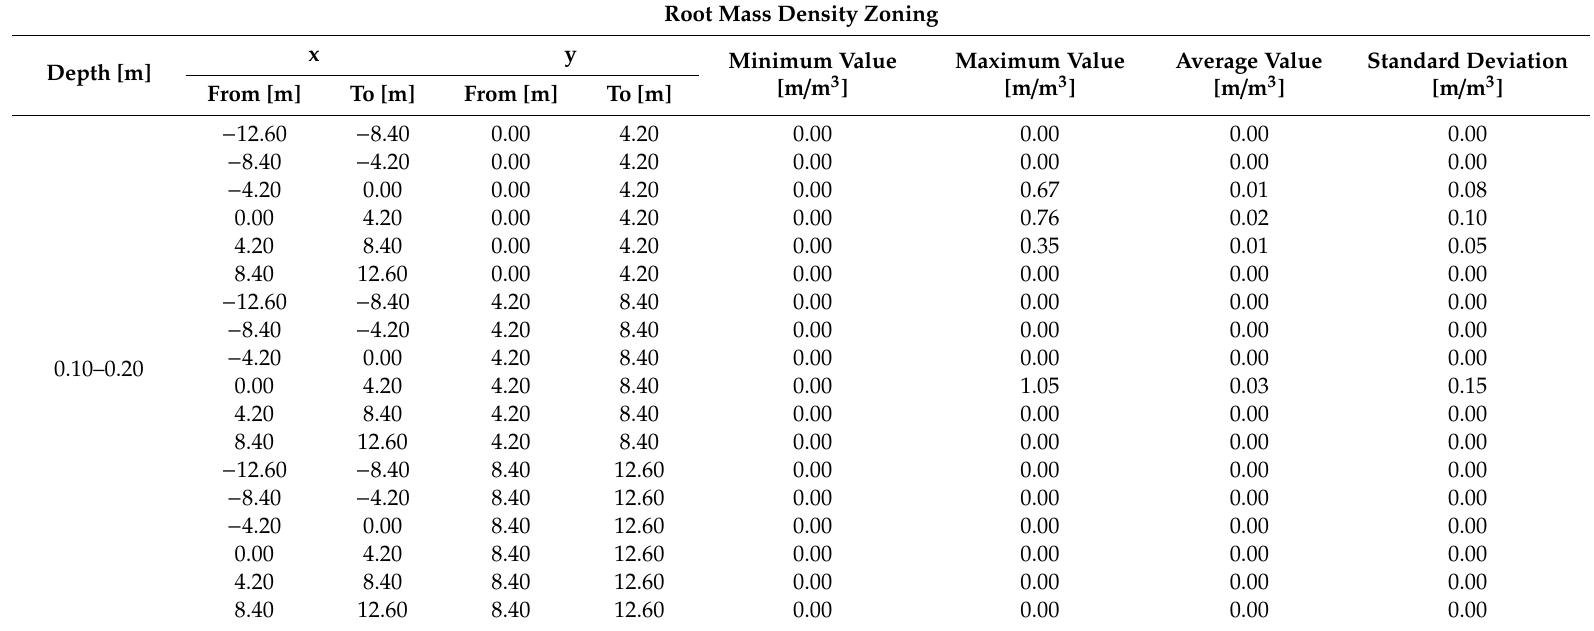
Table 1. Root mass density zoning for the investigated